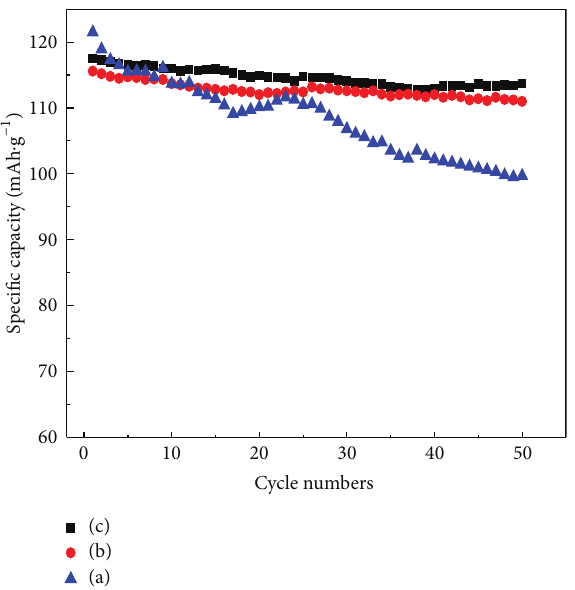
Figure 3: Cycle performance of cells (a) Li/LiMn 2 O 4 , (b) Li/ Li 1.02 Mn 1.92 Al 0.02 Fe 0.02 Cr 0.02 O 4 , and (c) Li/Li 1.02 Mn 1.92 Al 0.02 Fe 0.02 Cr 0.02 O 3.92 F 0.08 at room